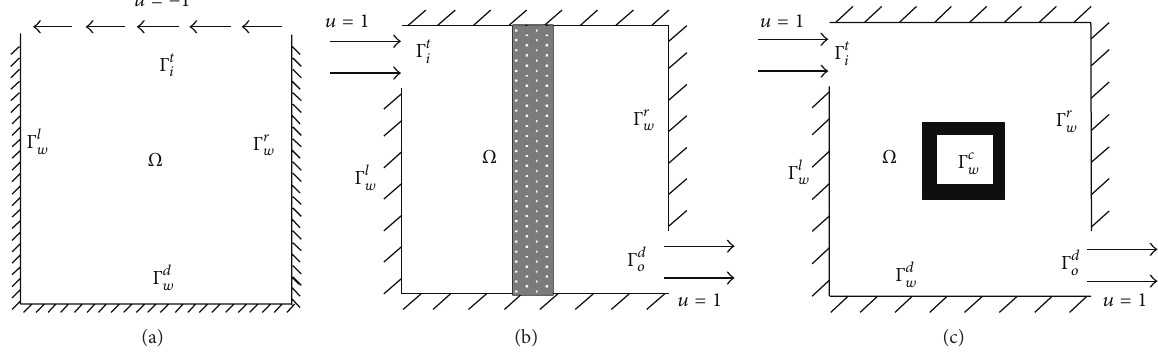
Figure 7: Three kinds of special models; (a) cavity flow model, (b) highway model, and (c) obstructs